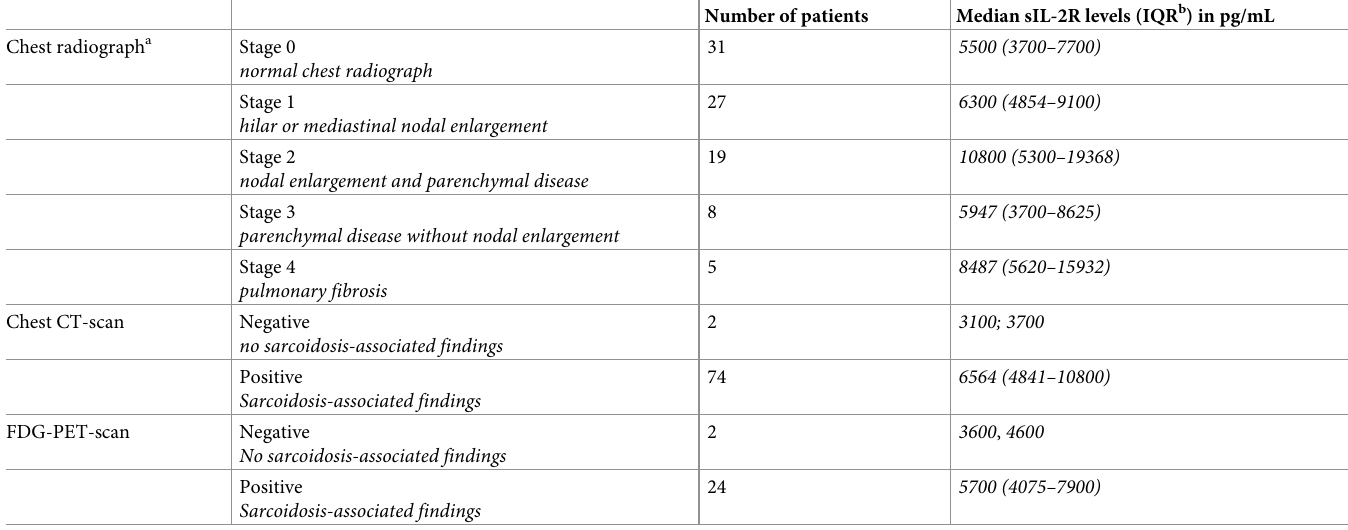
Table 3. Diagnostic parameters in sarcoidosis